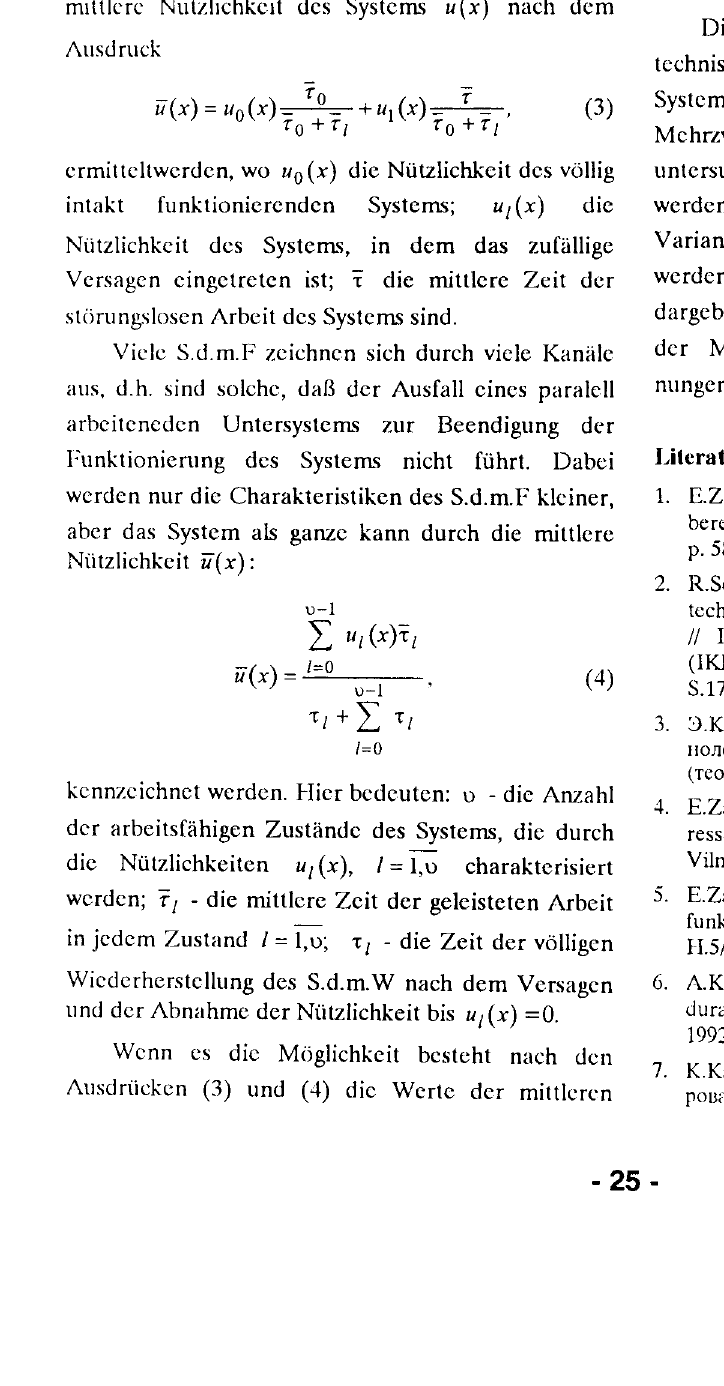
{I3i} der MS der mogliehen Varianten der